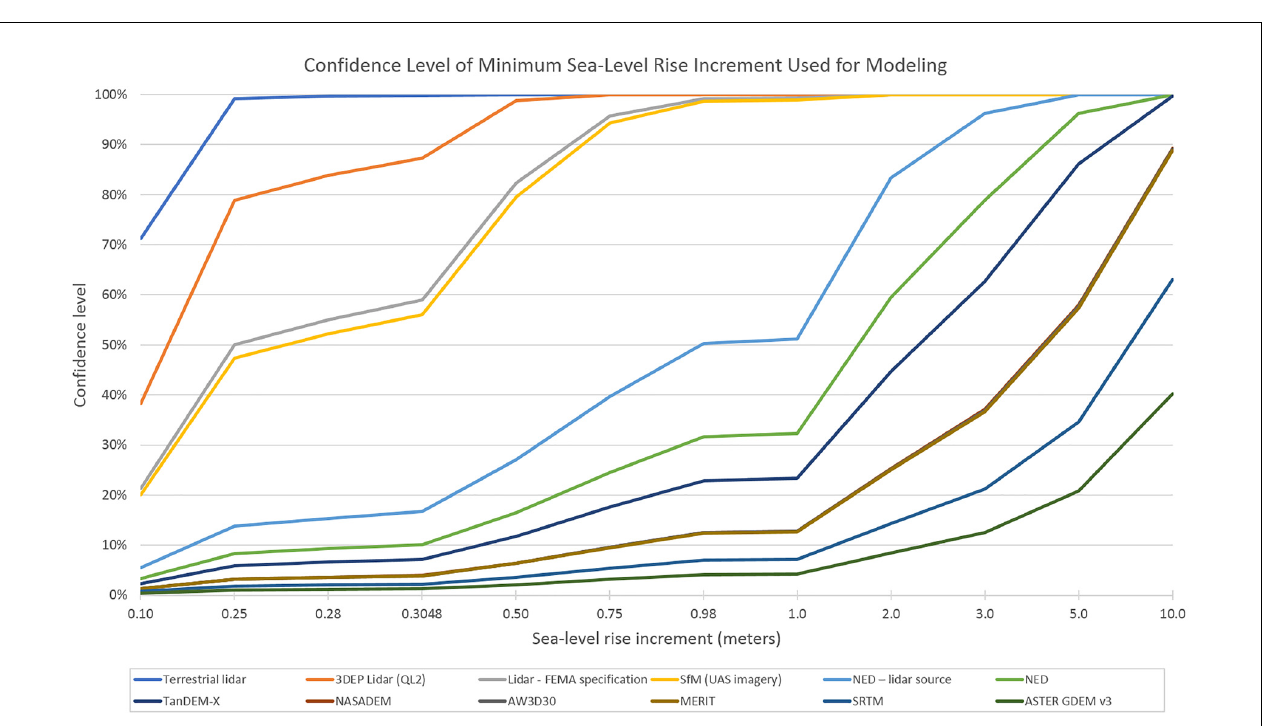
increases as the increment used for modeling increases. Note that when global DEMs and sub-meter increments of SLR (0.5 m or less) are used, the confidence is very low (in the 0–10% range).